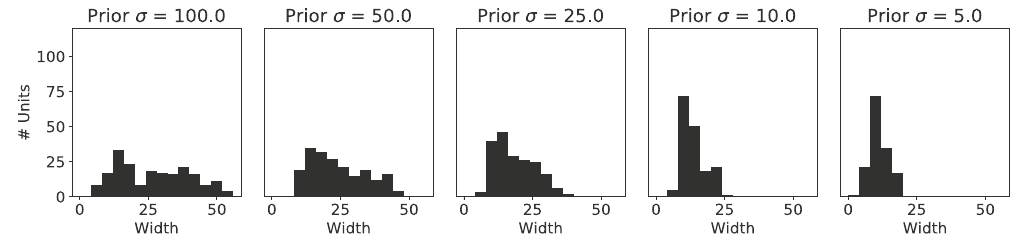
Figure 13. Tuning curves become narrower for sharper prior. A histogram of the full-width-at-half-maximum for all tuning curves is shown. For a sharper prior (right panel) tuning curves became narrower, effectively increasing the slopes of the tuning curves and thus the discriminability of different stimuli.